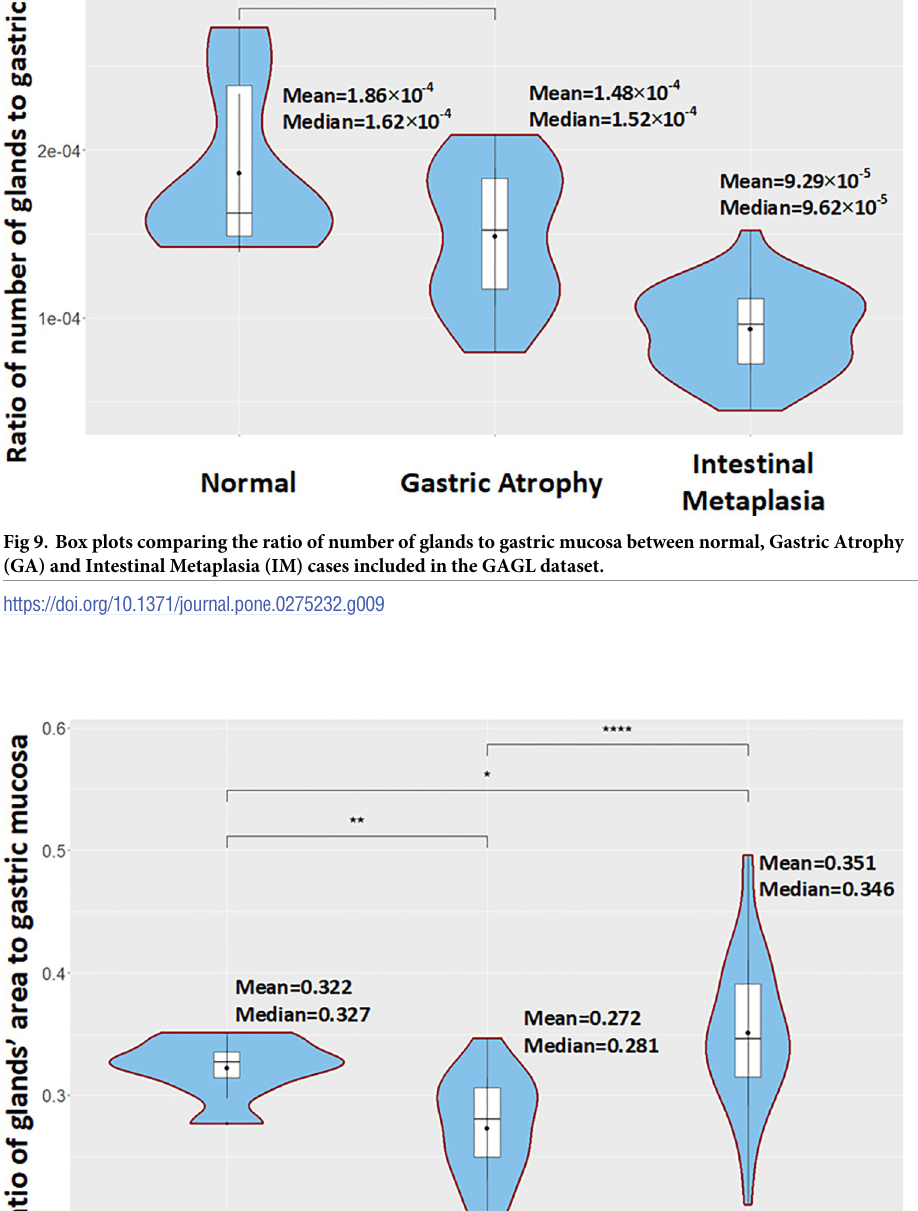
PLOS ONE | https://doi.org/10.1371/journal.pone.0275232 December30,